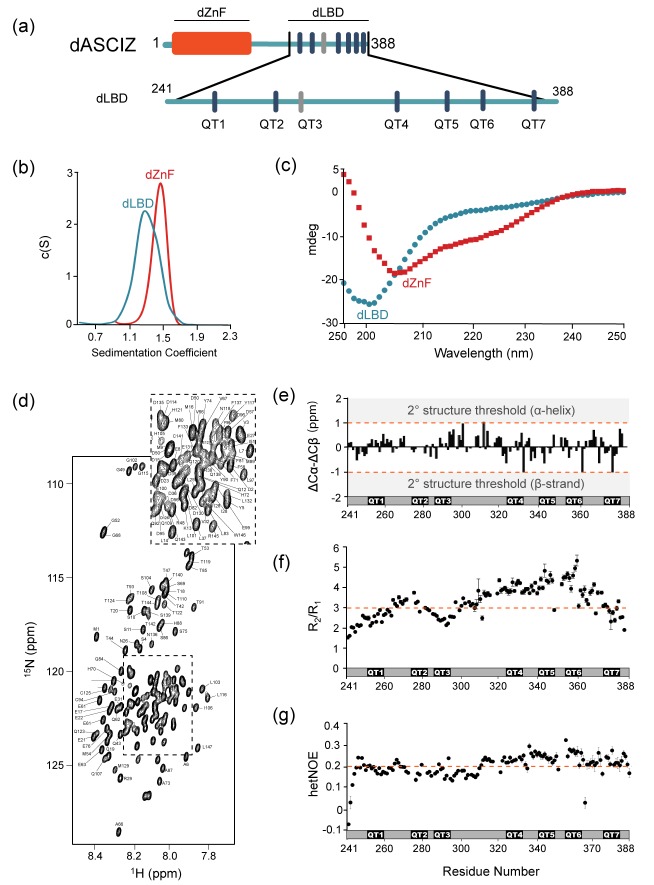
Domain structures of dASCIZ.(a) Domain structure of dASCIZ, showing the dZnF domain (red) and 7 LC8 binding motifs in its C-terminal domain (blue). Dark blue bars indicate predicted TQT motifs and gray bars indicate the TMT motif (QT3) identified in this study. (b) Sedimentation velocity analysis of the dZnF domain (red), collected at 10°C, and the dLBD (blue), collected at 25°C. (c) Far UV CD spectrum of the ZnF domain (red squares) and the dLBD (blue circles), both collected at 10°C. (d) [15N−1H]-BEST-TROSY spectrum at 850 MHz showing backbone assignments for 133 non-proline residues. Unassigned peaks correspond to the two additional N-terminal residues from the expression vector. The spectrum was recorded at 10°C. (e) A plot of secondary chemical shift differences versus residue number. ΔCα and ΔCβ values were calculated by subtracting the random coil chemical shifts (Tamiola et al., 2010) from the experimentally determined. ΔCα − ΔCβ values < ±1.0 ppm are considered not significant. (f) Plots of R2/R1 and (g) heteronuclear NOE values measured at 10°C indicate high level of disorder. A dotted line is placed at the average value to aid in visualization. Segments corresponding to LC8 recognition motifs, QT1, QT2, QT3, QT4, QT5, QT6, and QT7 are shown. Additional structural characterization of the dLBD by circular dichroism and gel filtration chromatography is shown in Figure 2—figure supplement 1.10.7554/eLife.36258.007Figure 2—source data 1.Tables containing the NMR data that were used to generate the graphs in Figure 2e–g.Cα and Cβ chemical shifts are listed for Figure 2e, R1 and R2 relaxation rates for Figure 2f, and Iunsat/Isat values for Figure 2g.